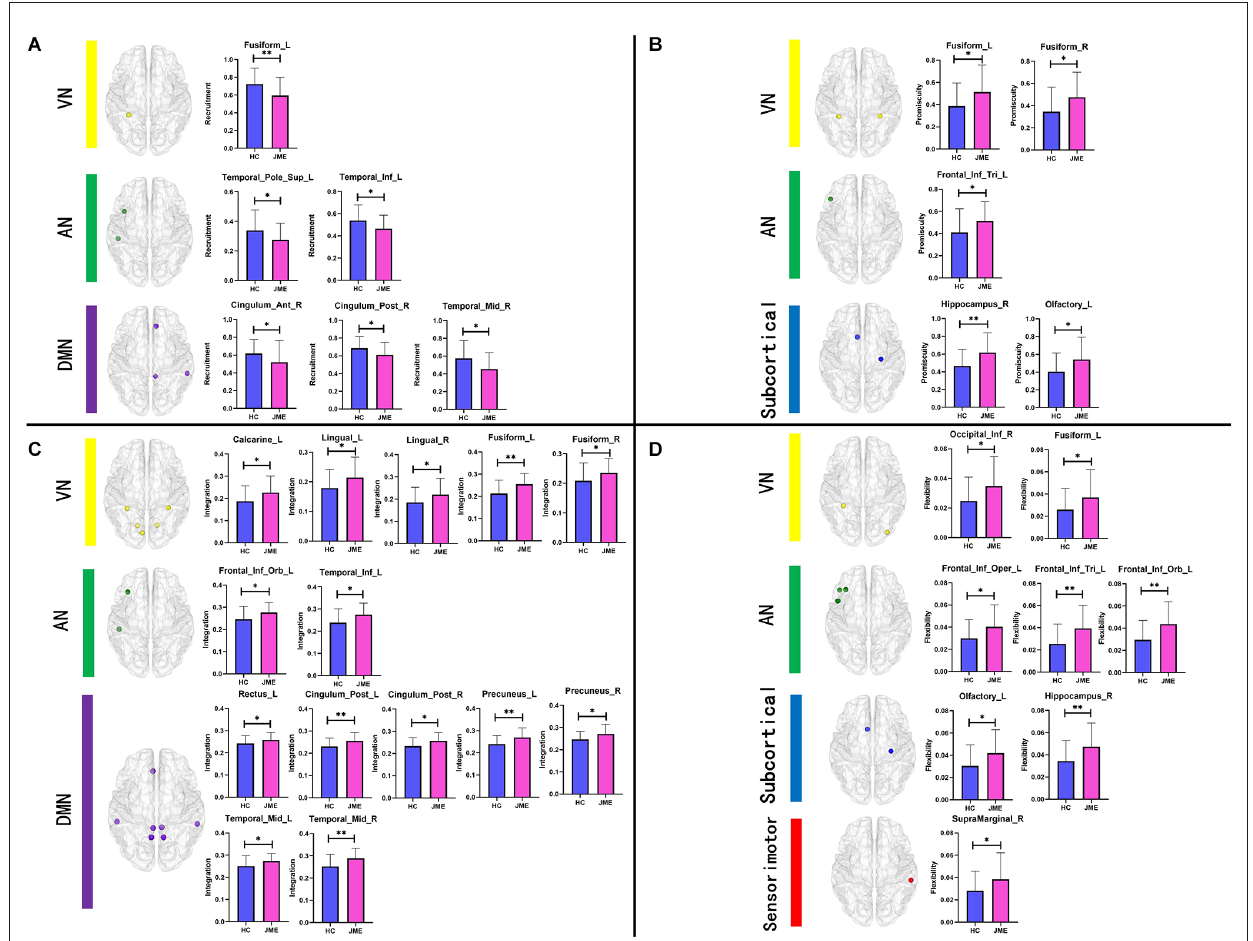
FIGURE5 Bar charts of group differences at the node level. Brain regions with significant differences in (A) recruitment, (B) promiscuity, (C) integration, and (D) flexibility. Asterisks represent differences between groups; ∗ denotes P < 0.05 and ∗∗ denotes P < 0.01, FDR-corrected.